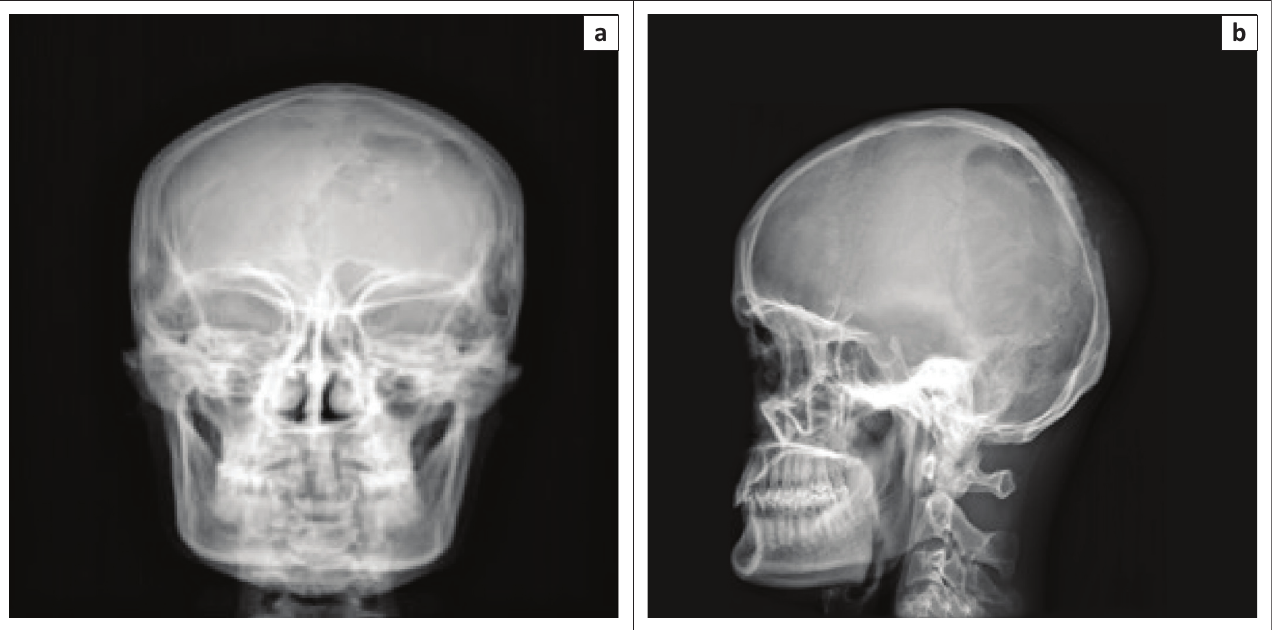
FIGURE 1: (a) X-ray of the skull PA view shows a well-defined lytic lesion with irregular margins in the left parietal bone and (b) X-ray of the skull lateral view shows the associated soft tissue component. No sclerosis or periosteal reaction is